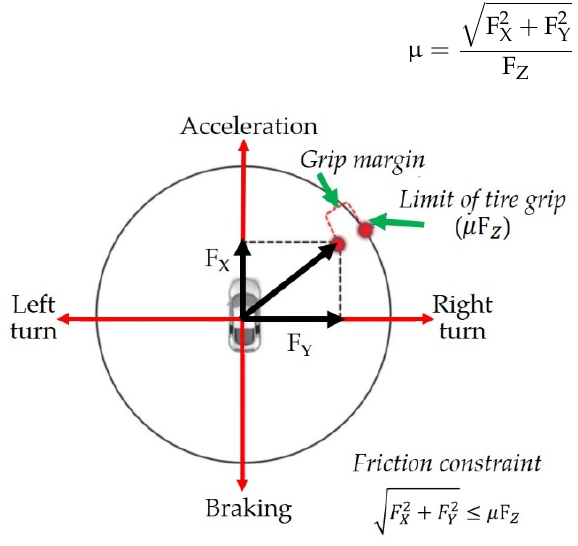
Figure 2. Friction circle during vehicle typical maneuvering